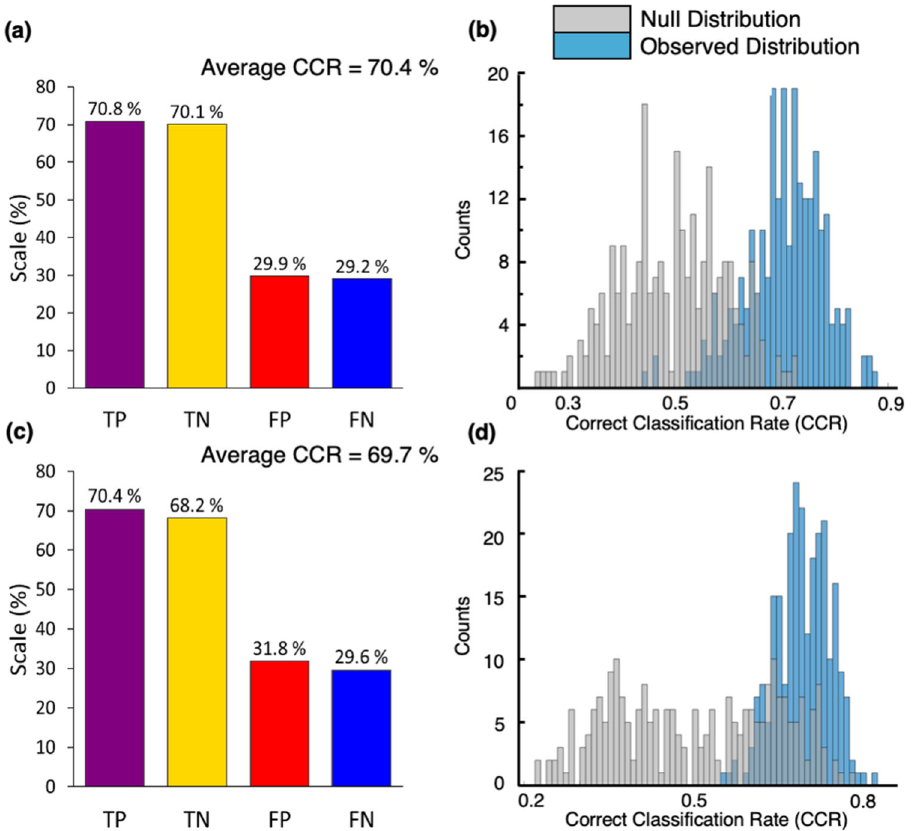
Fig. 1 PLS-DA classi fi cation models for (a, b) drug naïve PD vs. control and (c, d) medicated PD vs. control. a , c Classi fi cation rates for each model including true positive (TP, sensitivity), true negative (TN, speci fi city), false positive (FP), and false negative (FN). b , d Null distribution (grey bars) and observed distribution (blue bars) for each PLS-DA bootstrap model. The correct classi fi cation rate (CCR) were calculated from the test sets only ( n = 250 from the